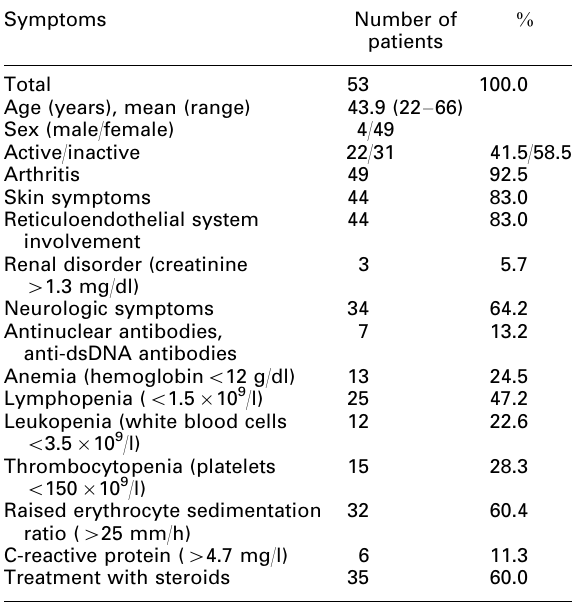
Table 1. Clinical and laboratory characteristics of patients with